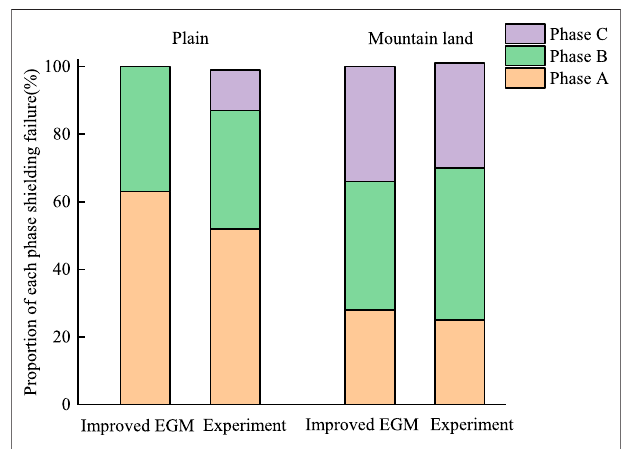
FIGURE 6 | Comparison chart of shielding failure proportion of each phase line.